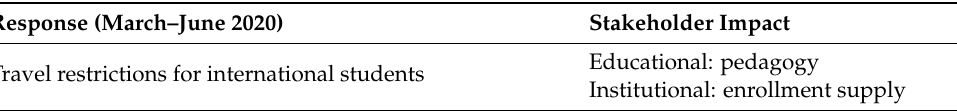
Table 4. Impacts of the COVID-19 response for the first semester of 2020 at Graduate School